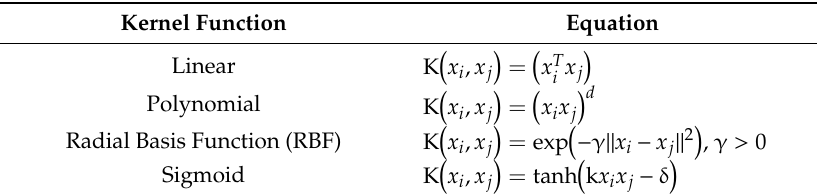
Table 3. Support vector machine (SVM) kernel